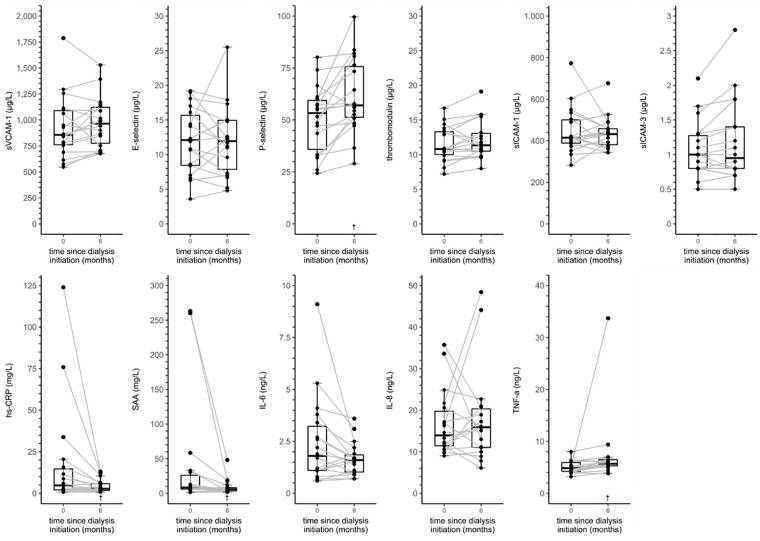
Boxplots and individual trajectories of serum biomarkers of endothelial dysfunction and low-grade inflammation over time in incident hemodialysis patients.Abbreviations: hs-CRP, high-sensitivity C-reactive protein; IL-6, interleukin 6; IL-8, interleukin 8; NA, not applicable; SAA, serum amyloid A; sICAM-1, soluble intercellular adhesion molecule 1; sICAM-3, soluble intercellular adhesion molecule 3; sVCAM-1, soluble vascular cell adhesion molecule 1; TNF-α, tumor necrosis factor alpha. †
P value < 0.05 vs. baseline based on linear mixed model analyses with a random intercept.